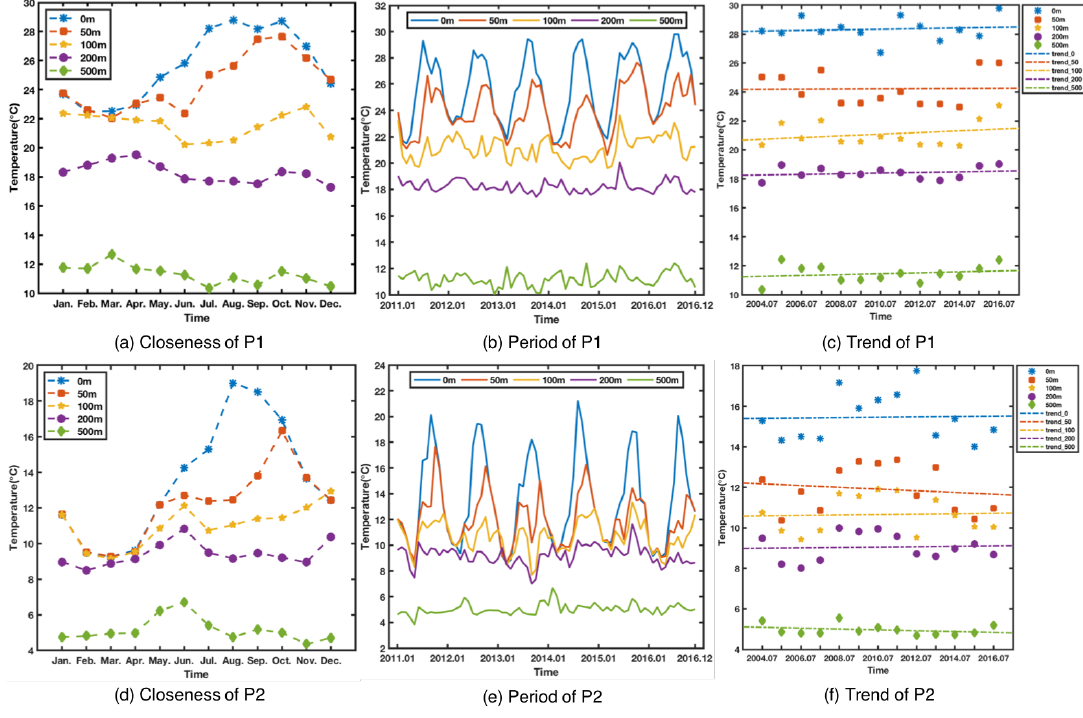
Figure 3. Temporal dependencies in different